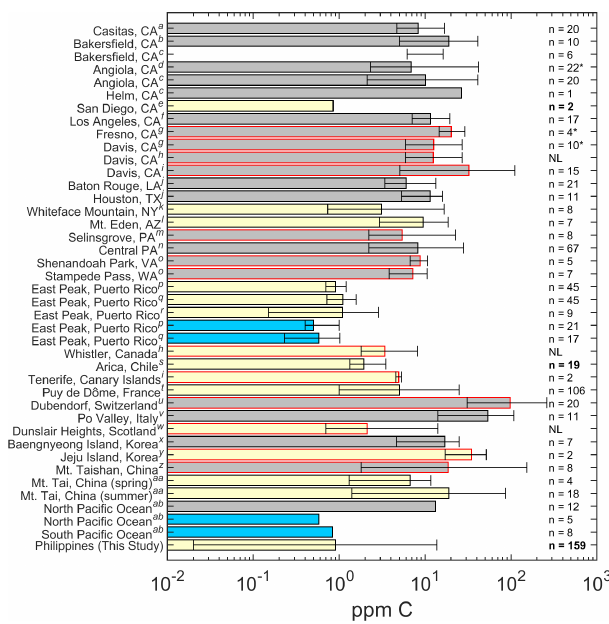
Figure 1. TOC (or dissolved organic carbon, DOC, if TOC values were unavailable) concentrations reported for past studies in rela- tion to this work organized by continent. Bars represent the average values, and the error bars represent the minimum and maximum values. The absence of a solid bar means that no average was avail- able. No error bars means that there was no range given, and “ ∗ ” indicates that the median value was reported rather than an average. Gray, yellow, and blue bars represent studies looking at fog, clouds, and rain, respectively. Bars that are outlined in black are studies that used TOC, and bars outlined in red are studies that used DOC. The n values represent the number of samples used in the study, and NL means that the number of samples was not listed. Bolded n values denote airborne samples. This figure is similar to Fig. 2 in Herckes et al. (2013) with additional information presented and organized by continent. The superscript letters used in the figure